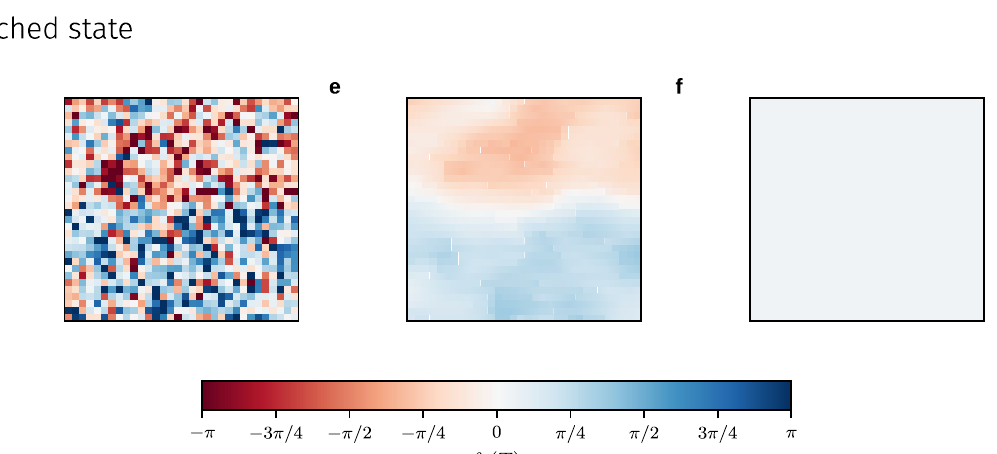
approximately (cid:4) π = 4 or π = 4, respectively. In Fig. 5a, d, we do not control the coupled Kuramoto oscillators, and we observe increasing phase differences over time. Using the loss function ð Θ ð T ÞÞ shows that AI Pontryagin can steer the system of J 2 coupled oscillators towards (cid:4) π = 4 and π = 4 at the control time T (Fig. 5b, e). Oscillators that are located in the upper half of the square lattice in Fig. 5e reached phase values close to (cid:4) π = 4 (indicated by light orange pixels), while oscillators in the lower half of the same lattice reached phase values of approximately π = 4 (indicated by light blue pixels). By employing the loss function ð Θ ð T ÞÞ , we can also use AI Pontryagin to synchronize the same J 1 system of coupled oscillators (dashed black line in Fig. 5c, f).